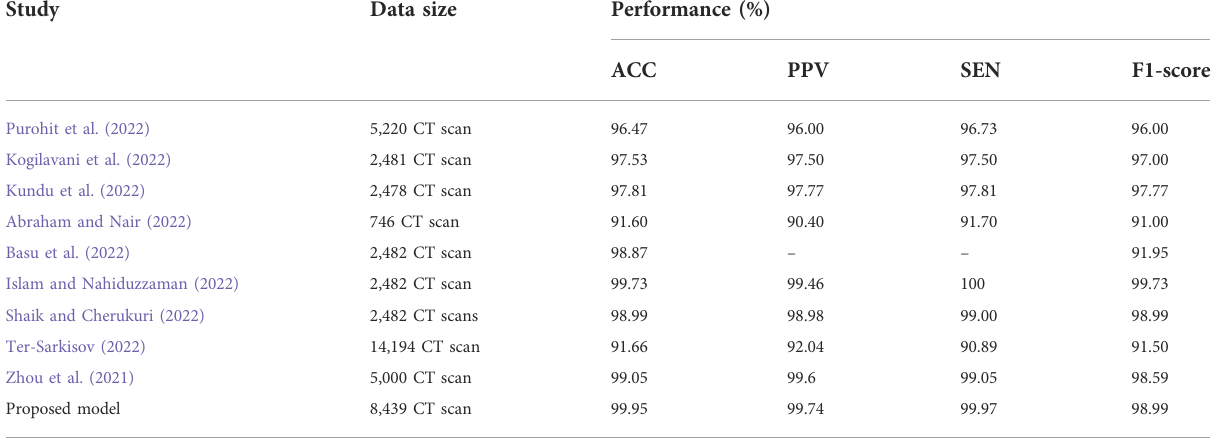
TABLE 7 Performance comparison of the stated COVID-19 identi fi cation model with others works on CT scan.